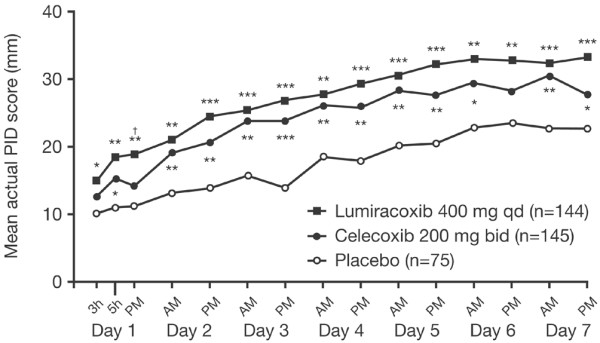
Mean actual pain intensity difference during seven days of treatment.